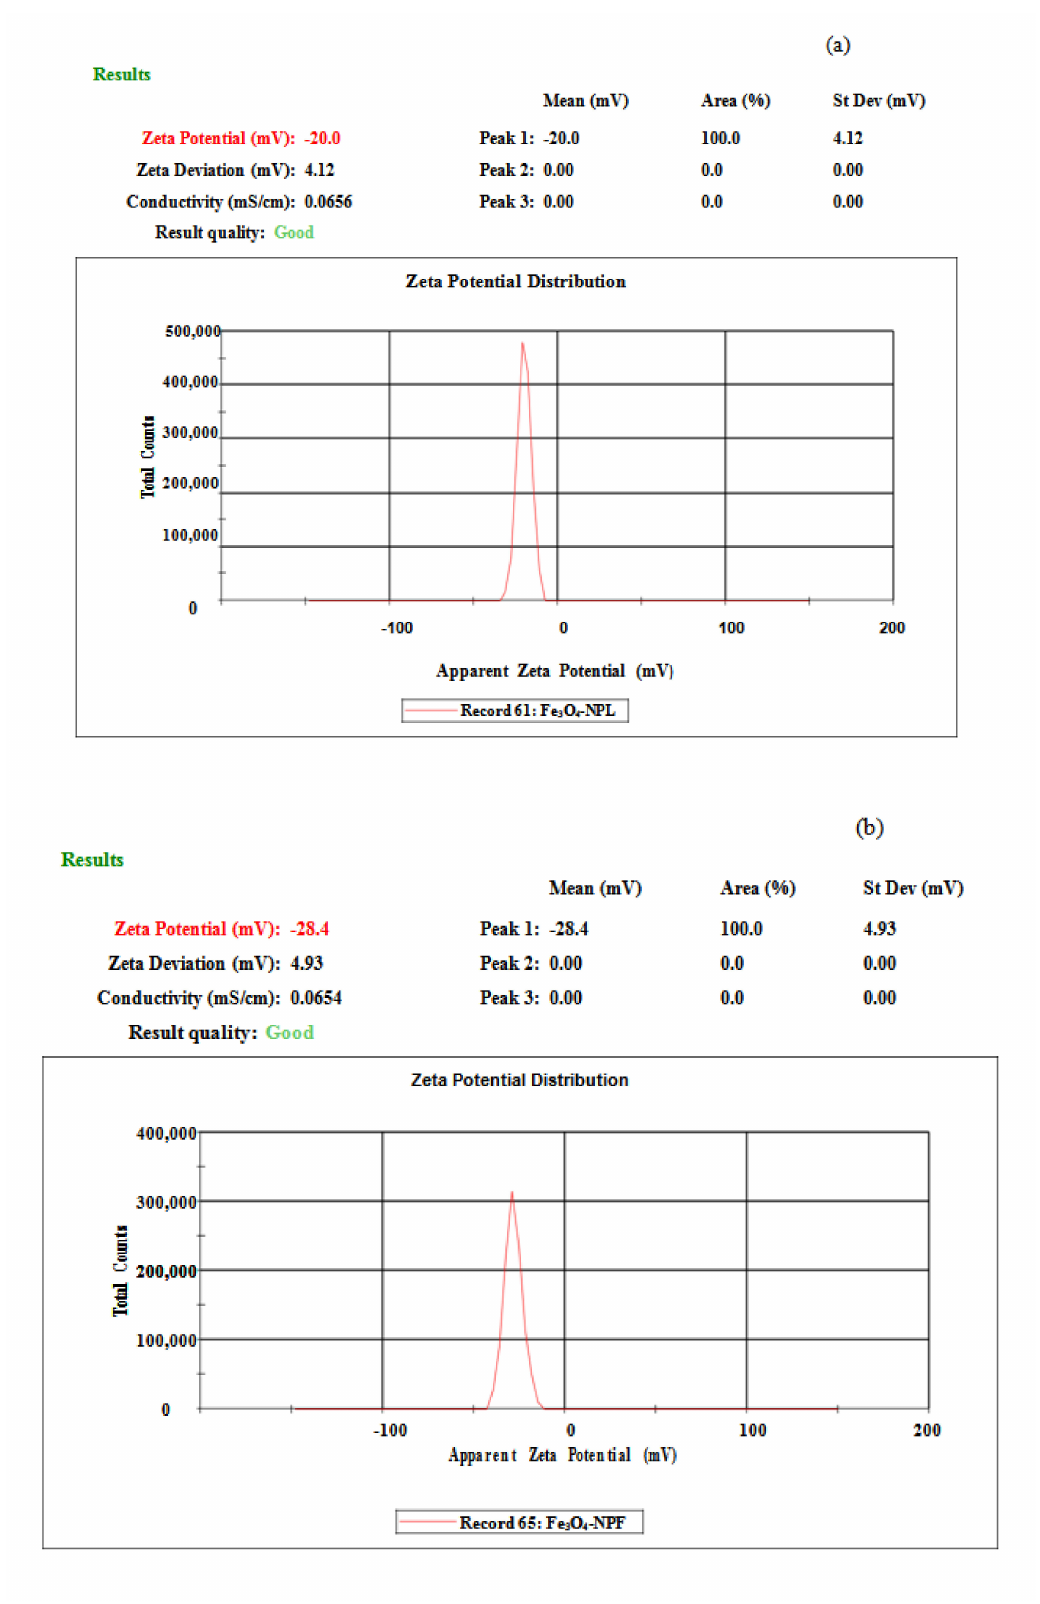
Figure 8. Zeta potential of ( a ) Fe 3 O 4 -NPL and ( b ) Fe 3 O 4